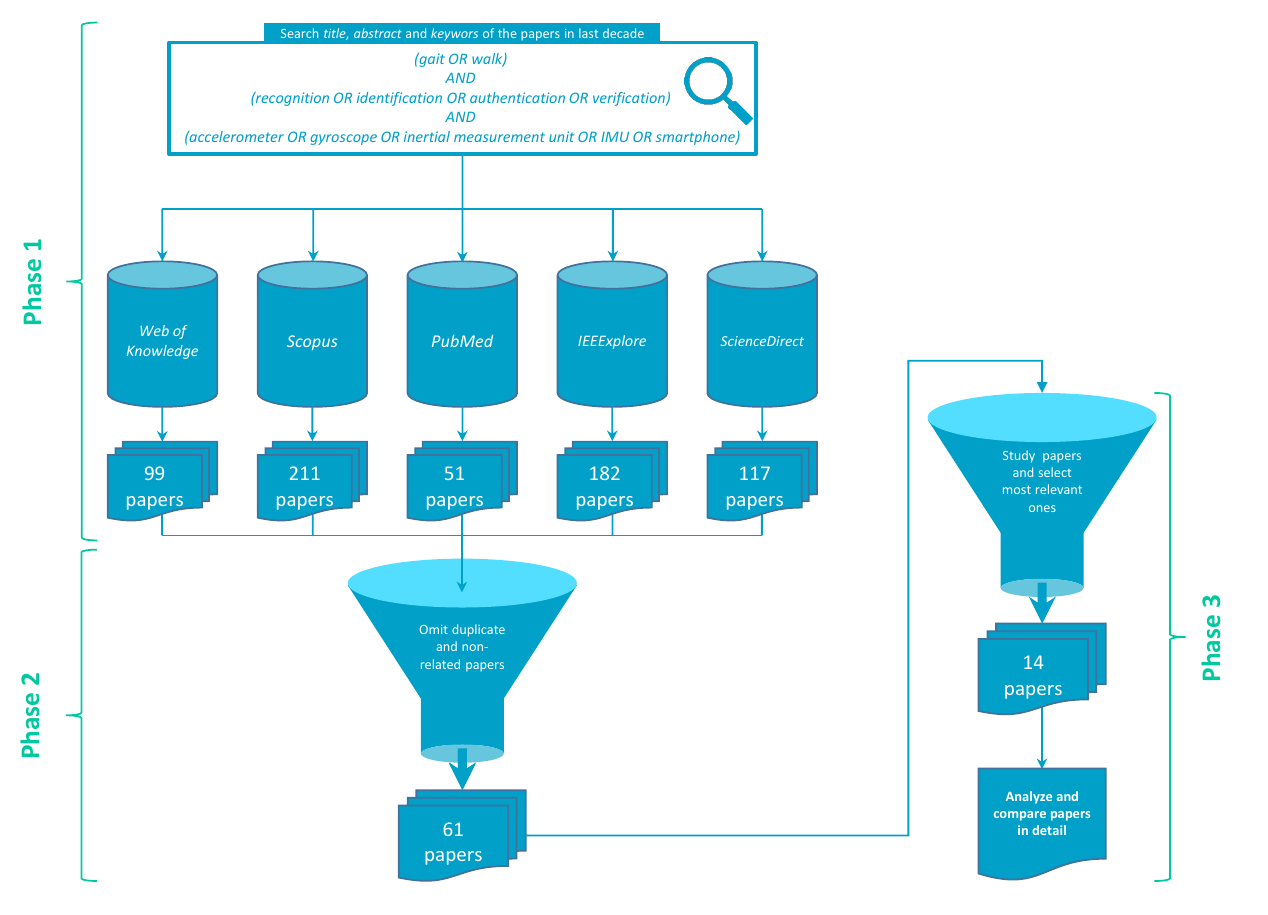
Figure 1. Detailed flowchart of a review